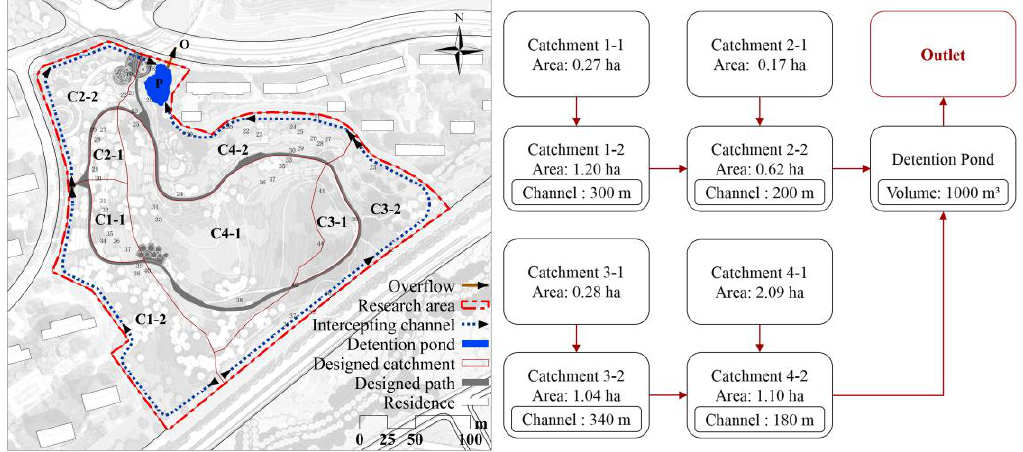
Figure 5. Facilities layout and design workflow diagram for S1.